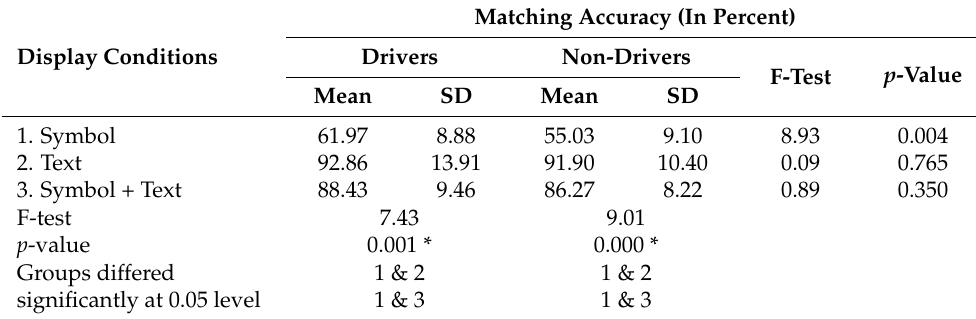
Table 6. Matching accuracy of drivers and nondrivers vs. display